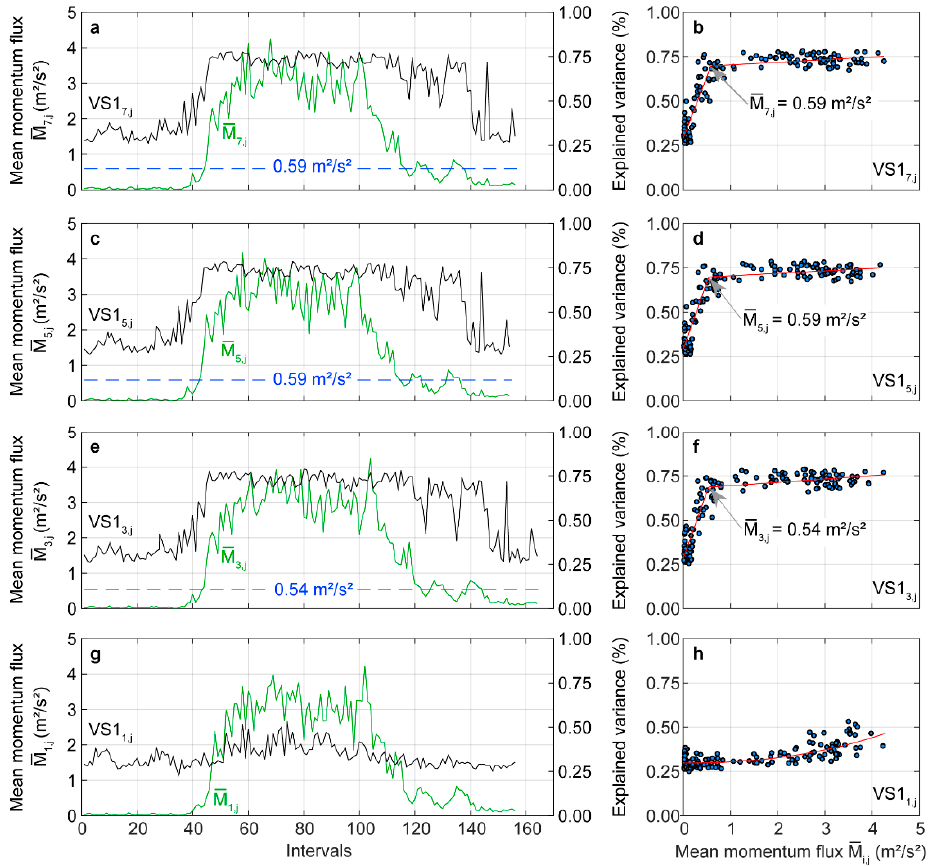
Figure 6. ( a , c , e , g ) Explained variance associated with the non-oscillatory ( NOS i,j ) singular spectrum analysis (SSA) component ( VS 1 i,j with i = 1, 3, 5, 7) as a function of mean momentum flux at canopy top ( M i,j ) on 30 January 2019. The red lines that are shown in the subplots in the right column of the figure were calculated with ( b , d , f ) two-phase regression models and ( h ) a second-order polynomial regression model.